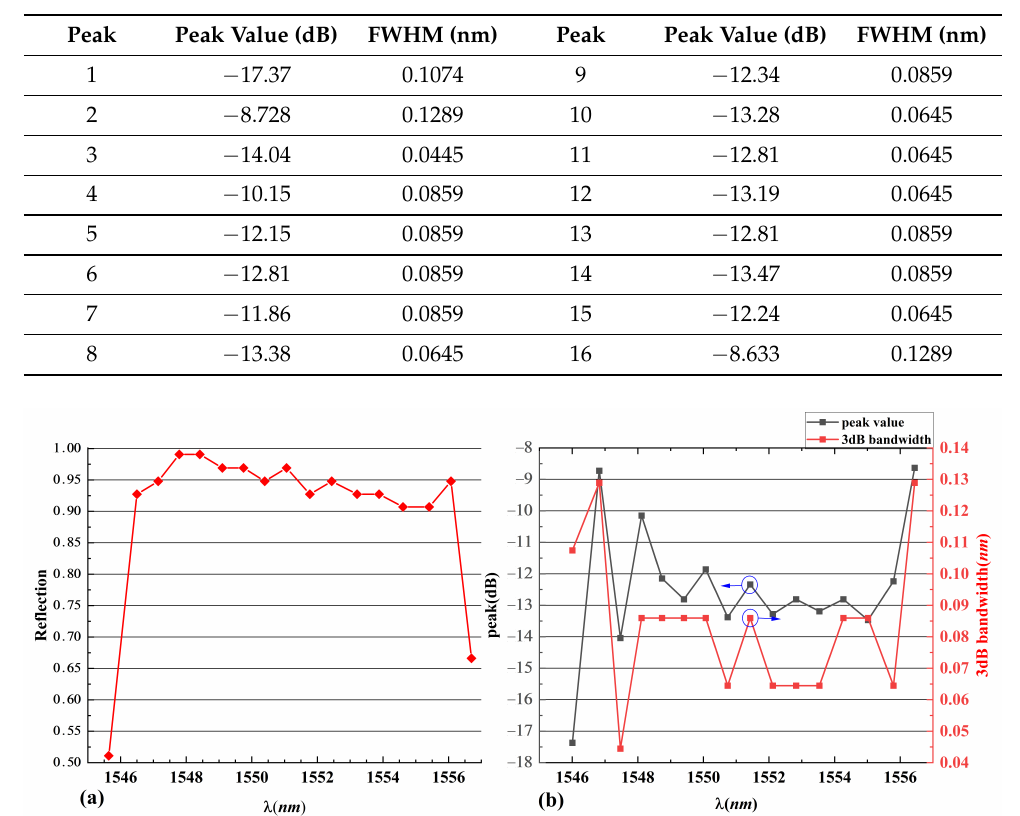
Table 1. Peak reflectance and FWHM at different transmission peaks in the reflection spectrum of a 2D chirped fiber grating.